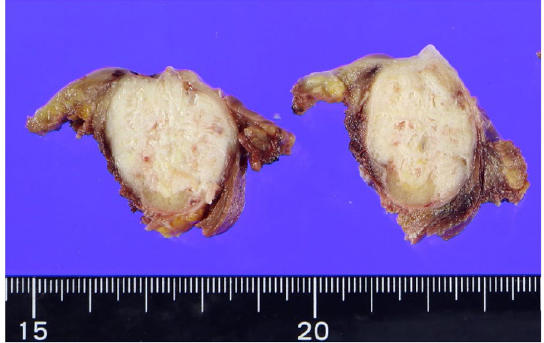
Fig. 6 Histological examination of biopsy. a An image showing atypical epithelium proliferating and forming small and large foci is partially exposed and ulcerated, and areas of continuity with the coated epithelium can be observed. b The lesions show a keratinizing tendency and some appear fenestrated ( 200). Tumor cells showing strong atypia, including nuclear staining and enlargement, discrepancy in nuclear size, × and irregularity in nuclear shape